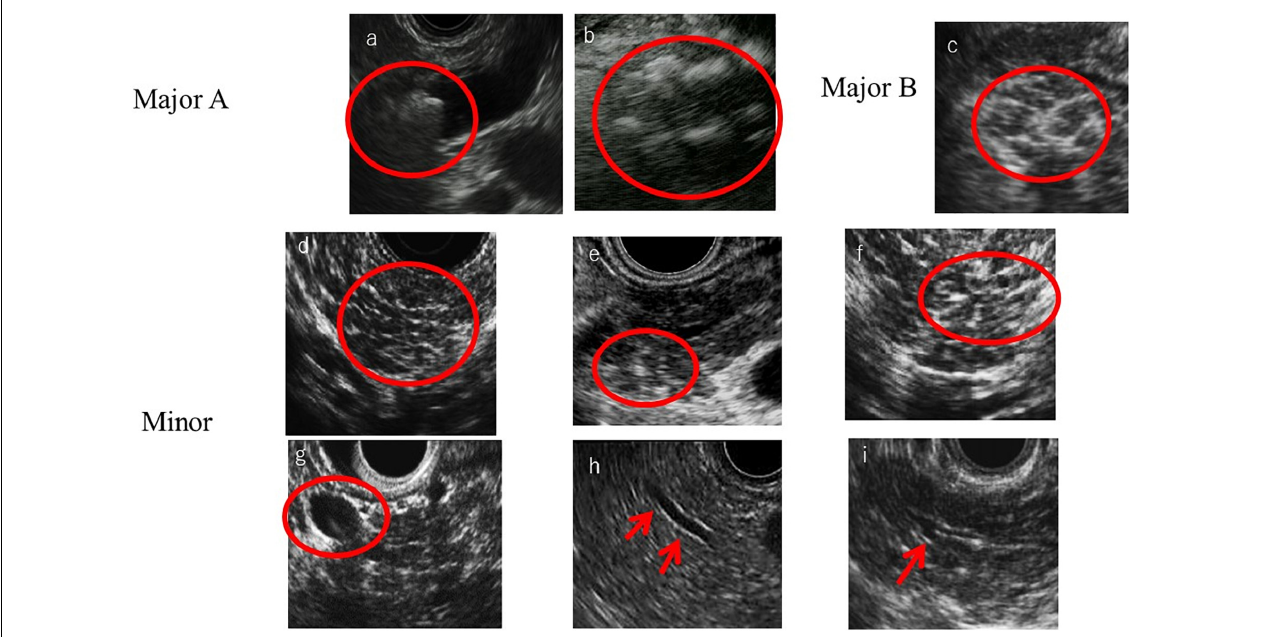
FIGURE 1 | Rosemont criteria items. (a) MPD calculi, (b) Hyperechoic foci with shadowing, (c) Lobularity with honeycombing, (d) Lobularity without honeycombing, (e) Hyperechoic foci without shadowing, (f) Strand, (g) Cyst, (h) Hyperechoic main pancreatic duct margin, and (i) Dilated side branches.